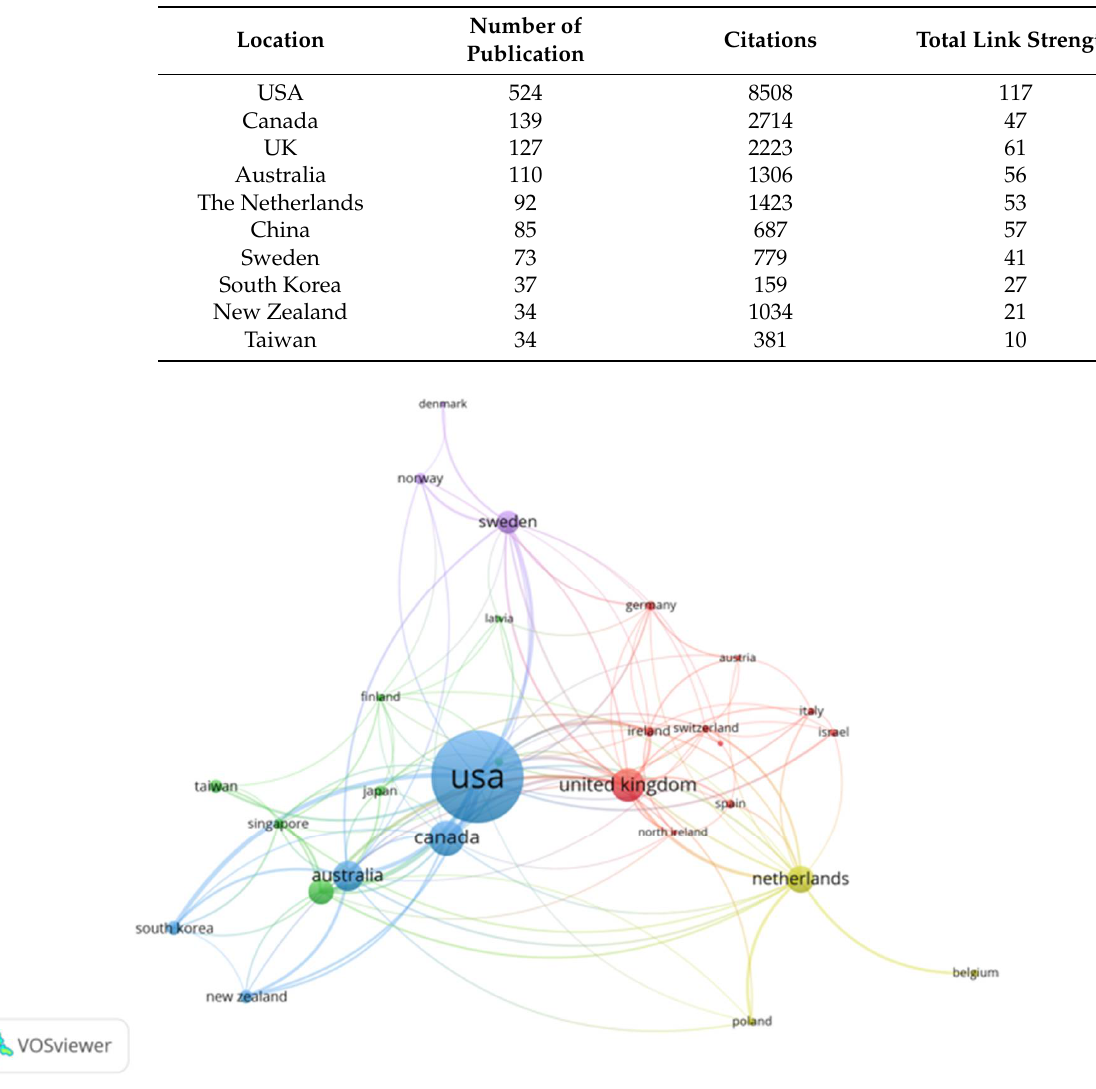
Figure 4: Network visualization of countries